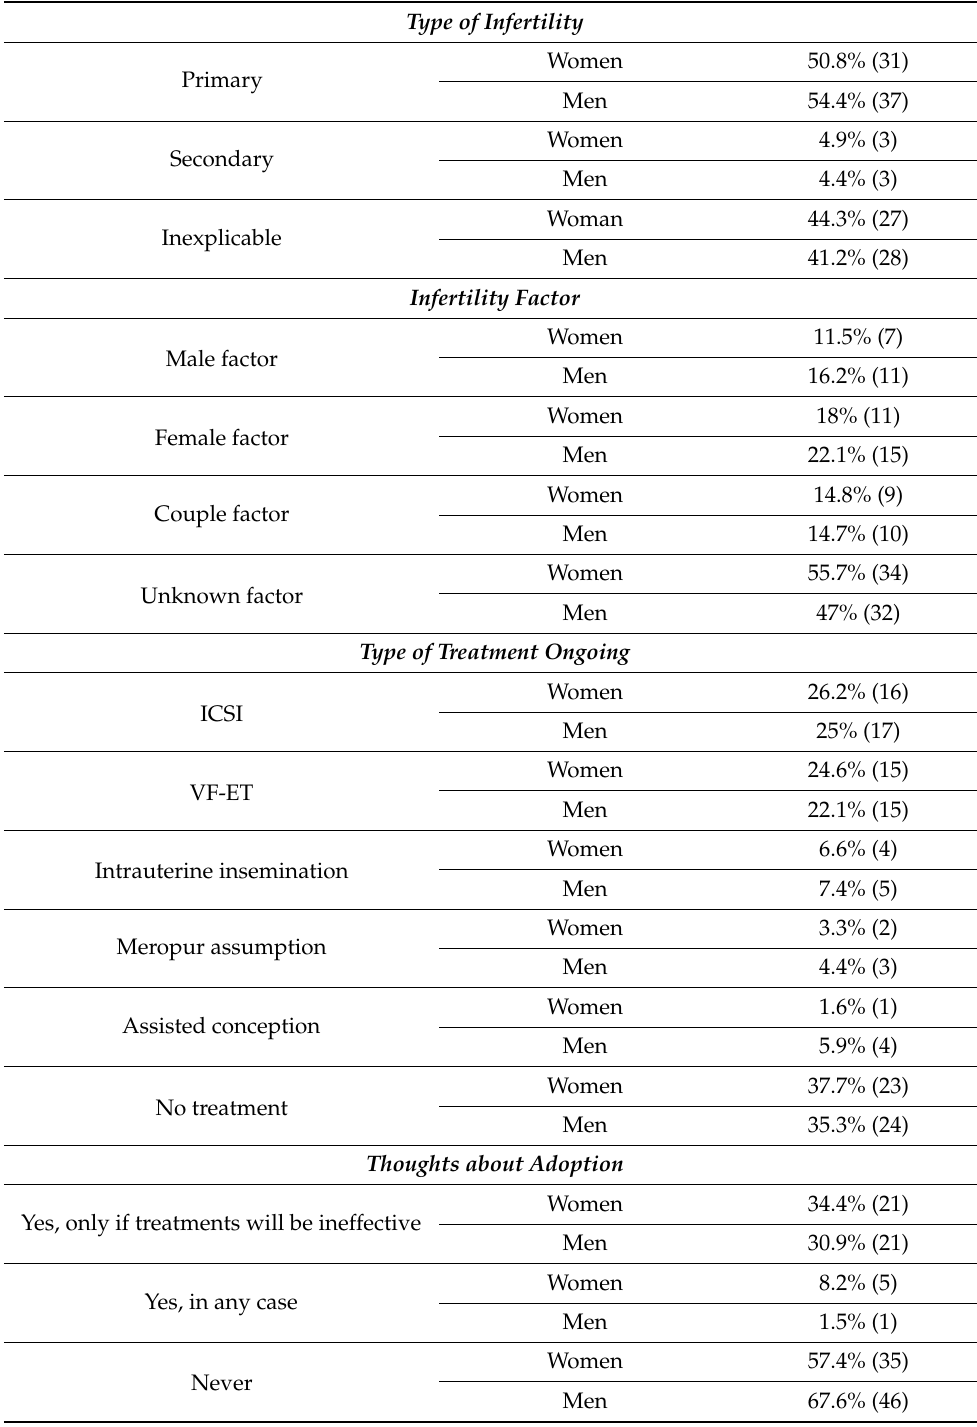
Table 2. Infertility information: type of infertility, infertility factors, ongoing treatments, and adoption